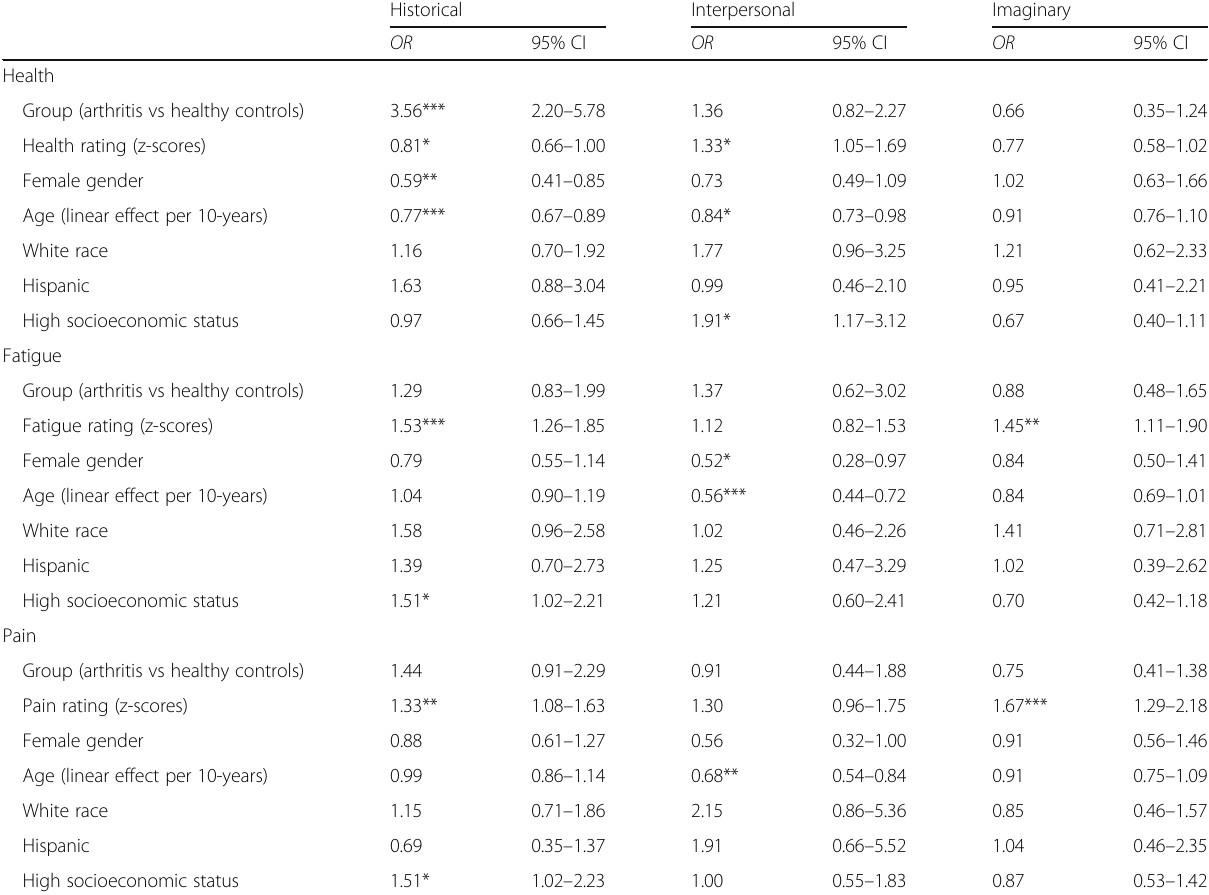
Table 3 Multiple logistic regressions predicting Historical, Interpersonal , and Imaginary comparison standards for ratings of health, fatigue, and